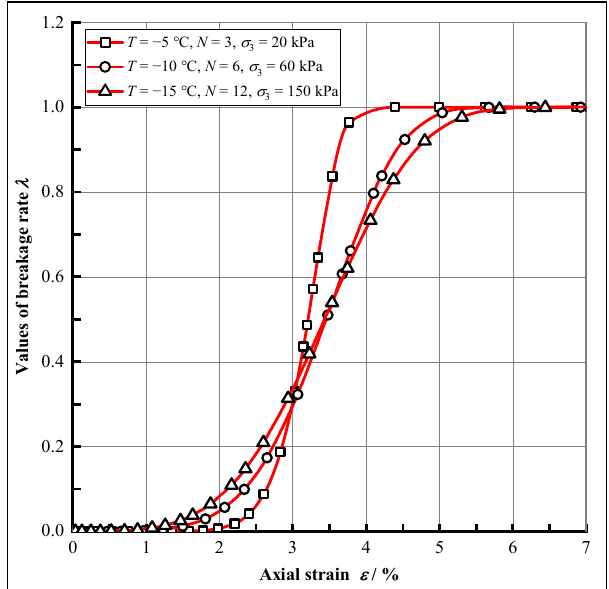
Figure 10. The changes law of the breakage rate.